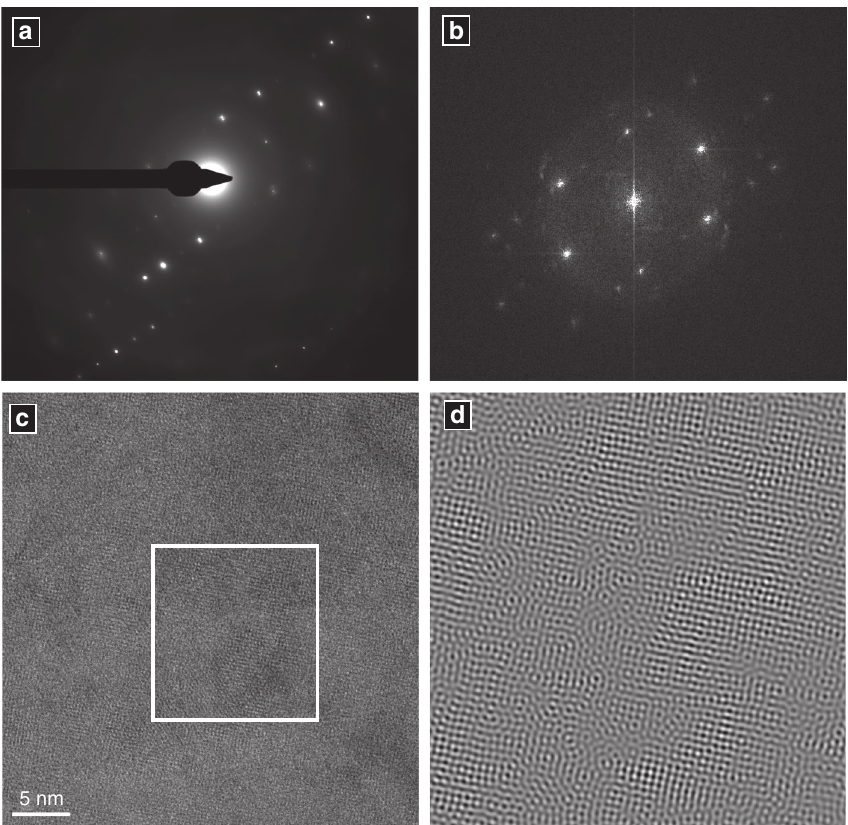
Fig. 4 Amorphous regions on crystal fringes. Electron diffraction patterns collected from O. universa during analytical session 1 ( a image plate detector, b Fourier Transform analysis of ( c )) display Debye-Scherrer rings (diffuse diffraction patterns around the image centre). These are typical of amorphous material. After fi ltering and inverse Fourier transformation ( d ) areas devoid of lattice fringes can be seen that are inconsistent with a crystalline material, but consistent with the presence of either ACC or organic material. Lattice fringes are visible as periodic parallel lines in c and